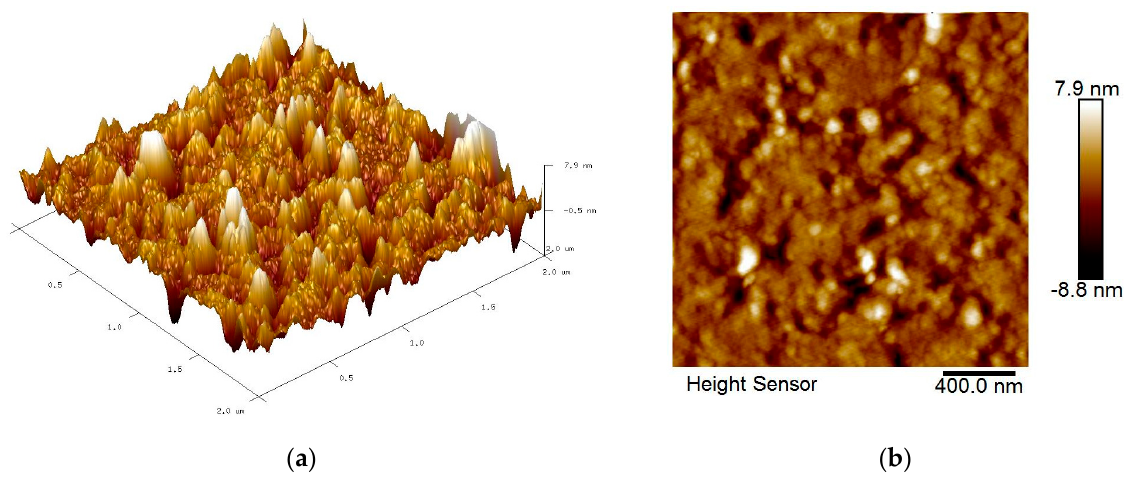
Figure 6. AFM images of PVA thin film: ( a ) 3D image and ( b ) 2D image.